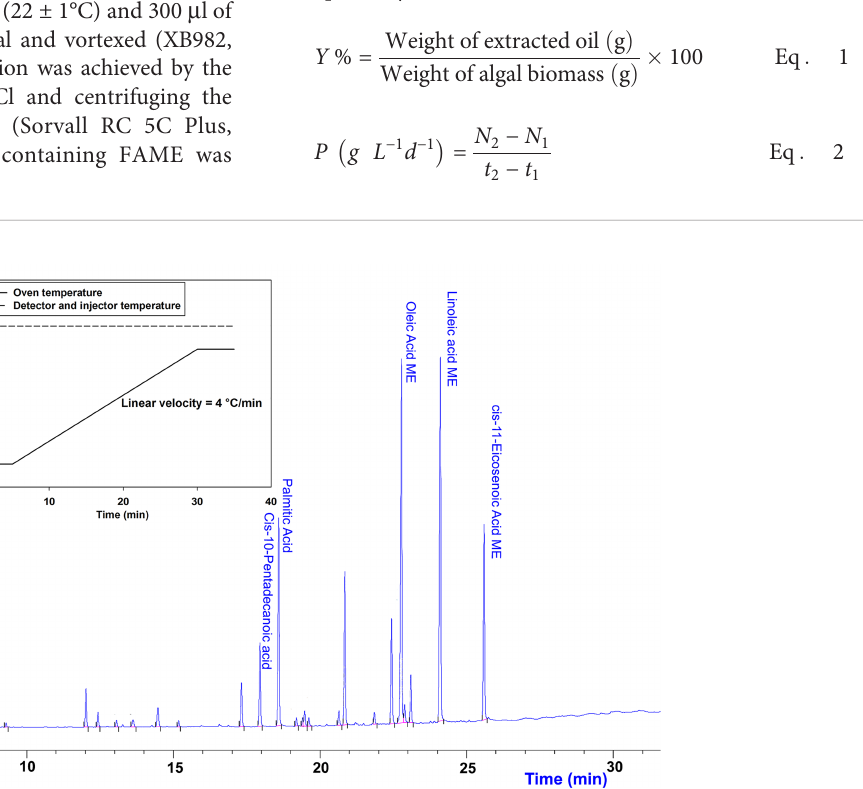
Figure 1 . A mix of 37-component FAME standard, Cat. No.